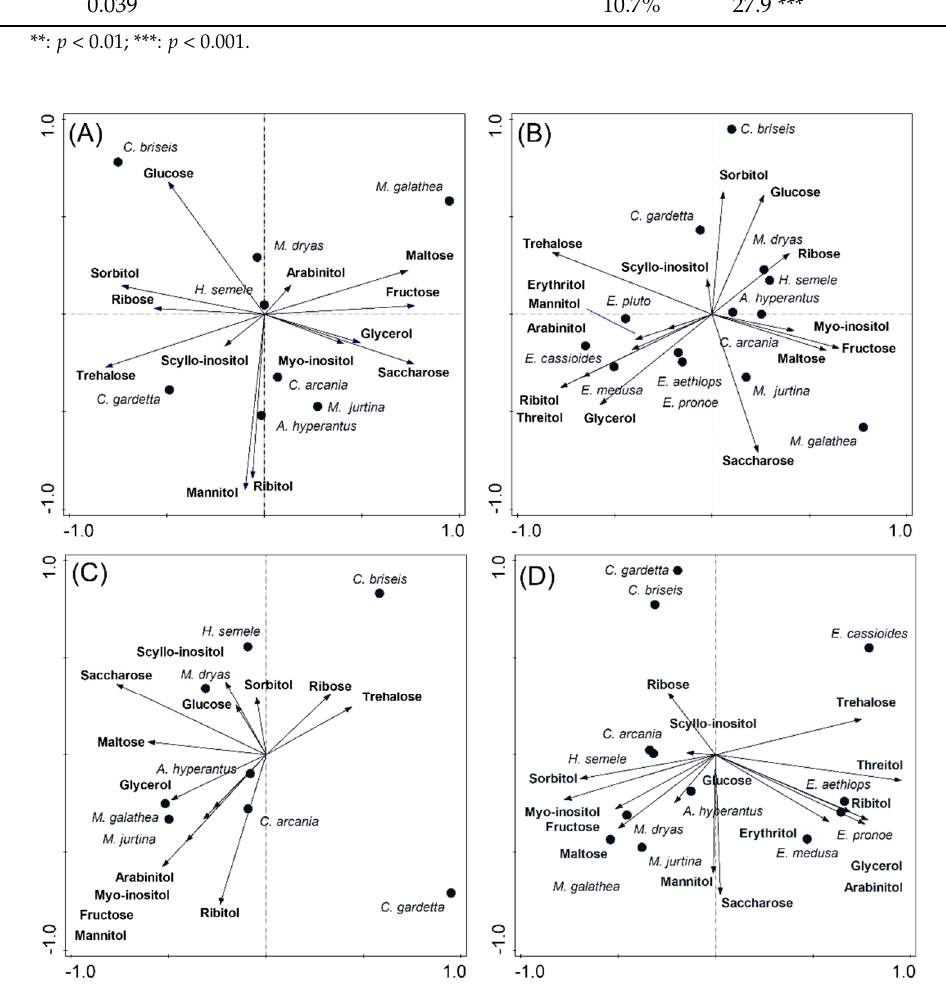
Figure 3. CCA ordination biplots, showing the distributions of putatively cryoprotectant com ‐ pounds in overwintering Satyrinae butterfly larvae. (A+C) : the eight species considered in this study. (B+D ): the analyses expanded by adding the five Erebia species from [15]. ( A+B ): Autumn the analyses expanded by adding the five Erebia species from [15]. ( A , B ): Autumn treatment analyzed treatment analyzed separately. ( C+D ): Winter treatment analyzed separately. See Supplementary separately. ( C , D ): Winter treatment analyzed separately. See Supplementary Figure S1 for the Figure S5 for the treatments analyzed together. treatments analyzed